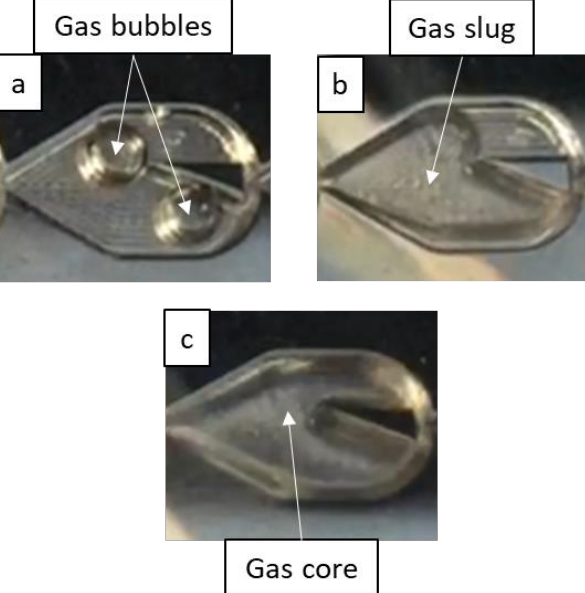
Figure 3. Flow regimes identified in this work. ( a ) Bubble flow, ( b ) slug flow, ( c ) annular flow.